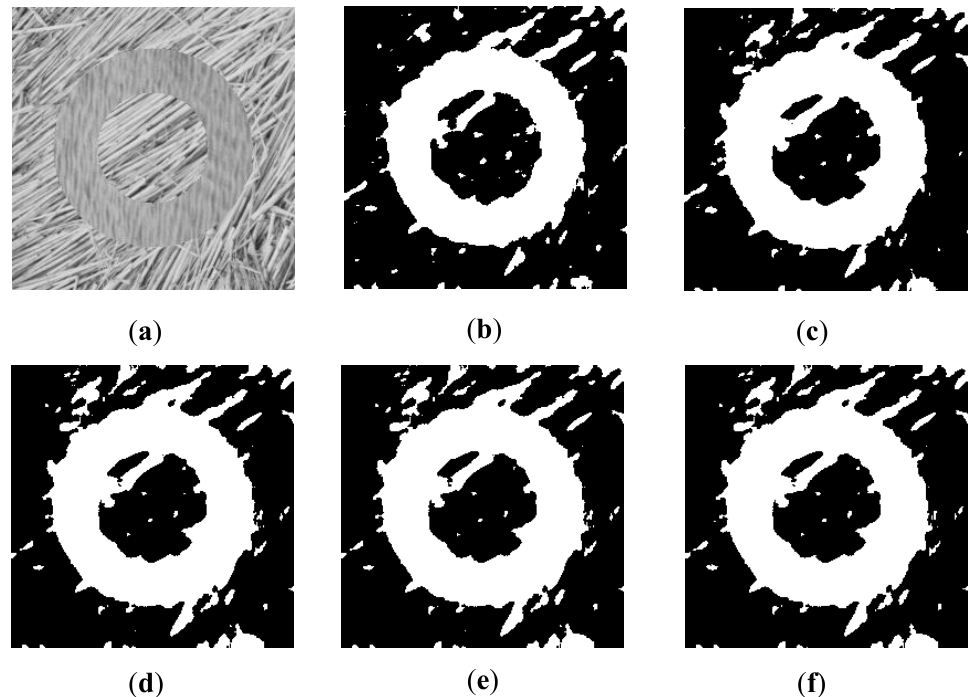
Figure 5. Segmentation results on Image4. ( a ) original image; ( b ) AFWDLMO; ( c )